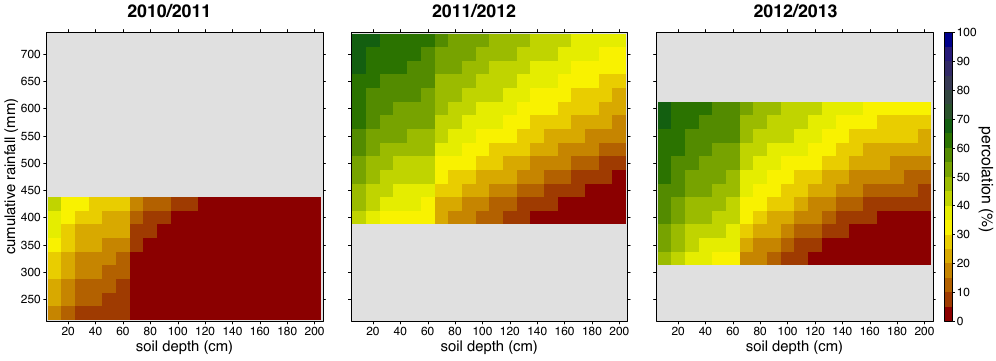
Figure 10. Simulated percolation vs. soil depth and rainfall amounts along the climatic gradient for three consecutive winter seasons with different rainfall depths and distribution patterns. Simulations were based on calibrated soil hydraulic properties of plots SM-1. The grey shaded areas display rainfall depths, which have not been reached in the study area within altitudes of 400–1000ma.s.l. according to cal- culated rainfall gradients. The points represent the plot-scale simulated percolation fluxes using optimal parameter sets for the single plots SM-1, SM-2 and